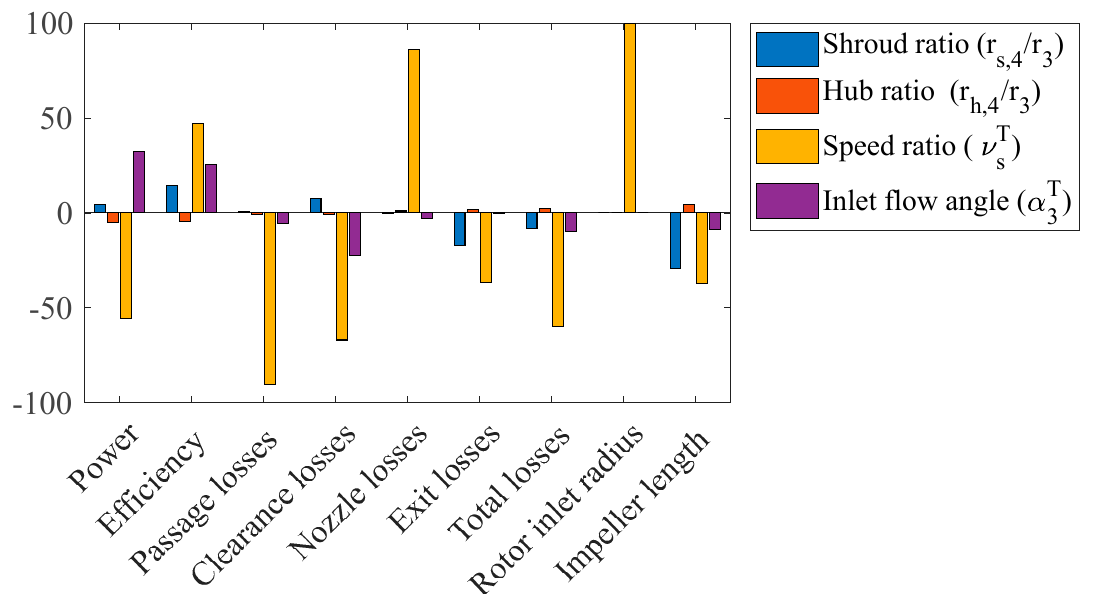
Figure 10. Sensitivity analysis of turbine’s performance parameters to the design parameters.